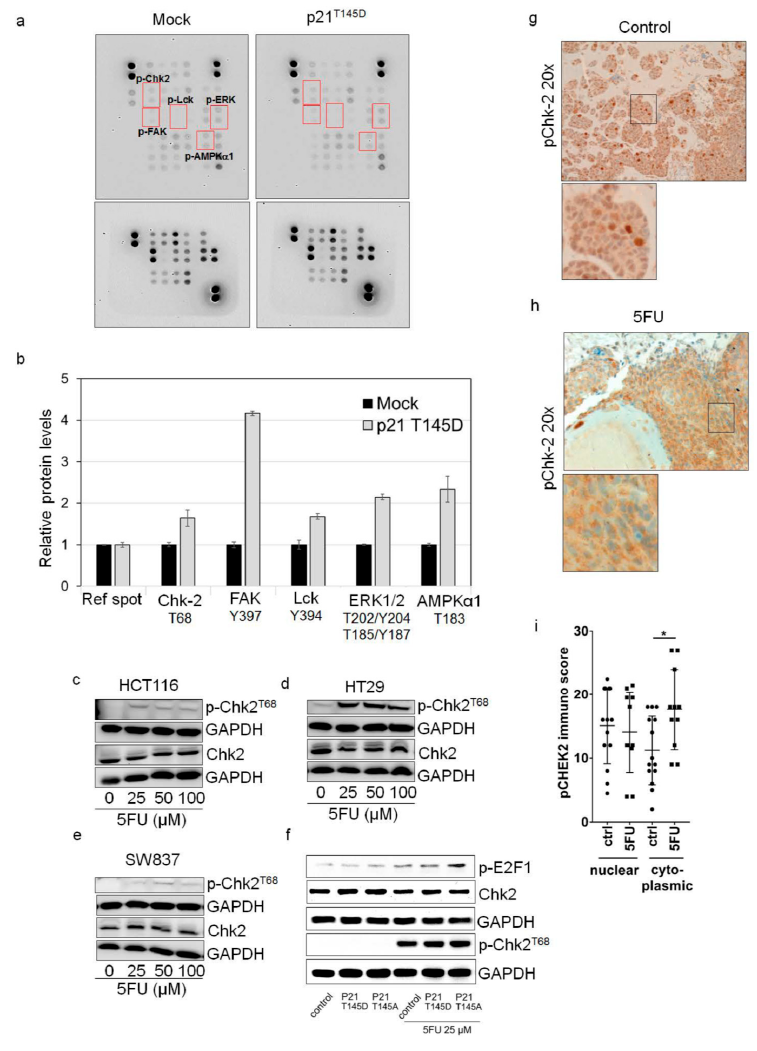
Figure 5. p21 inhibits pro-apoptotic effect of Chk2. ( a , b ) Expression levels of phospho-proteins in transfected cells. HCT116 cells were transfected with hyperphosphorylated p21 T145D . After 48 h of transfection, cells lysates were prepared and subjected to the Human Phospho-Kinase Array Kit (R&D systems). The expression levels of phosphorylated Chk2 (p-Chk2 T68 ) and Chk2 in 5FU-resistant HCT116 ( c ), HT29 ( d ), and SW837 ( e ) cells were determined by Western Blot. (The same lysates were loaded on two different membranes for Chk2 and pChk2 detection). For this, cells were treated with various concentrations of 5FU for 48 h. Dead cells were removed by washing with PBS and the remaining viable cells were collected to prepare protein lysates as mentioned in the Material and Methods sections. The blots were re-probed with GAPDH to confirm equal loading of the samples. ( f ) The expression levels of phosphorylated Chk2 (p-Chk2 T68 ), Chk2, and p-E2F1 in HCT116 cells transfected with hyperphosphorylated p21 T145D and unphosphorylatable p21 T145A in response to 5FU treatment were determined by Western Blot analysis. After 24 h transfection, cells were left untreated or were treated with 5FU (25 µ M) for further 48 h. Dead cells were removed by washing with PBS and the remaining viable cells were collected to prepare protein lysates. The expression of p-E2F1, p-Chk2 T68 and Chk2 were determined and the blots were re-probed with GAPDH to confirm equal loading of the samples. Immunohistochemical staining of p-chk2 T68 in CAM xenografts formed by HCT116 control ( g ) and HCT116 5FU-treated ( h ) cells. ( i ) p-chk2 T68 immunoscore in cytoplasmic and nuclear localizations in tumors of the HCT116 5FU-treated and untreated groups. * p < 0.05 versus non-treated